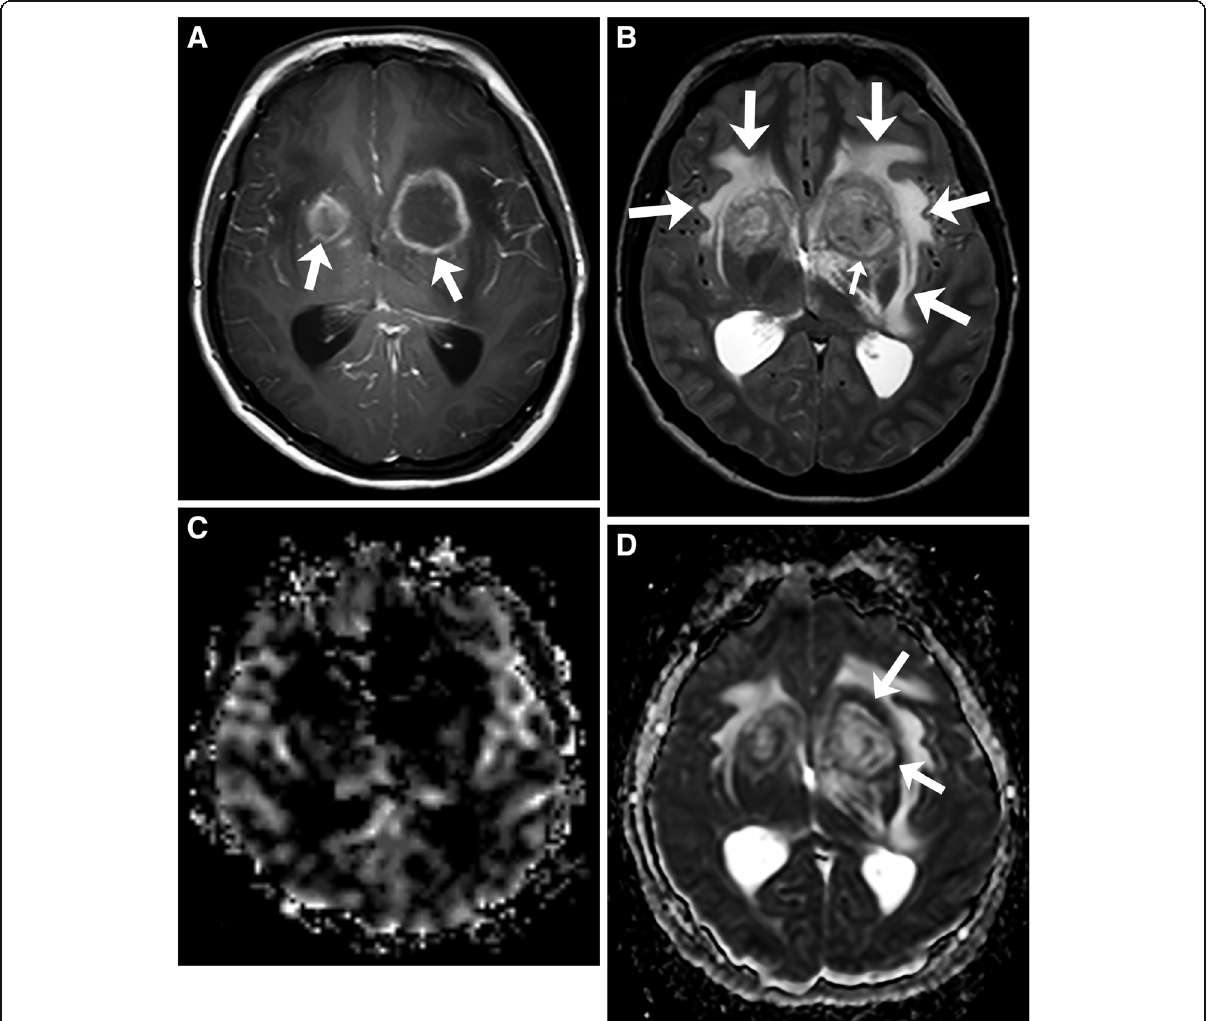
Fig. 3 Primary central nervous system post-transplant lymphoproliferative disorder. T1-weighted image with gadolinium ( a ) shows multiple ring enhancing masses (arrows) in the basal ganglia. T2-weighted image ( b ) shows extensive edema (arrows) and mild T2 isointense rims (small arrow). CBV map ( c ) demonstrates no increased perfusion. ADC map ( d ) shows restricted diffusion of the ring enhancing area (arrows)